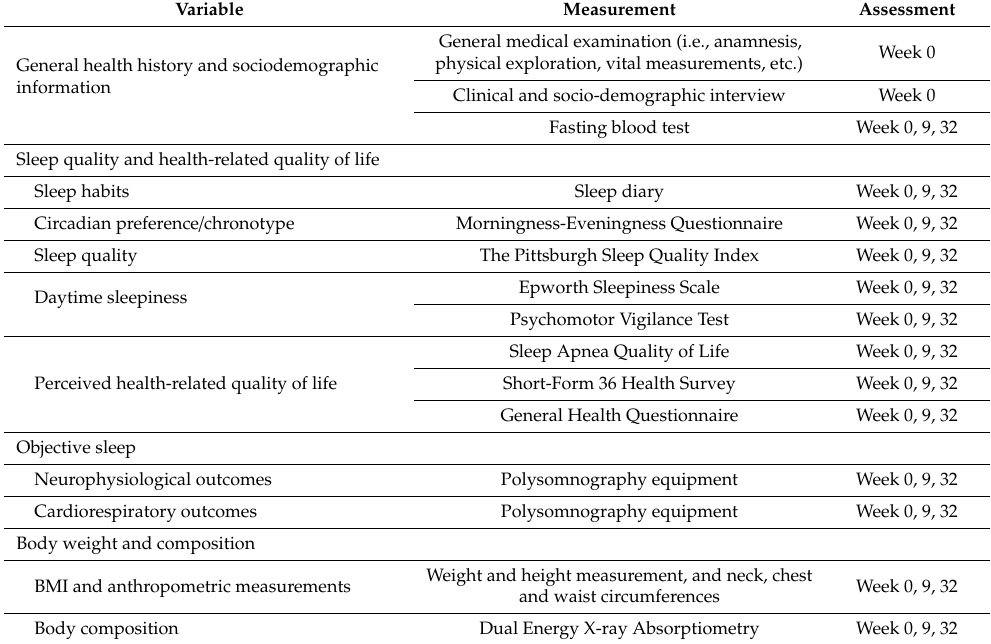
Table 2. INTERAPNEA study outcomes and